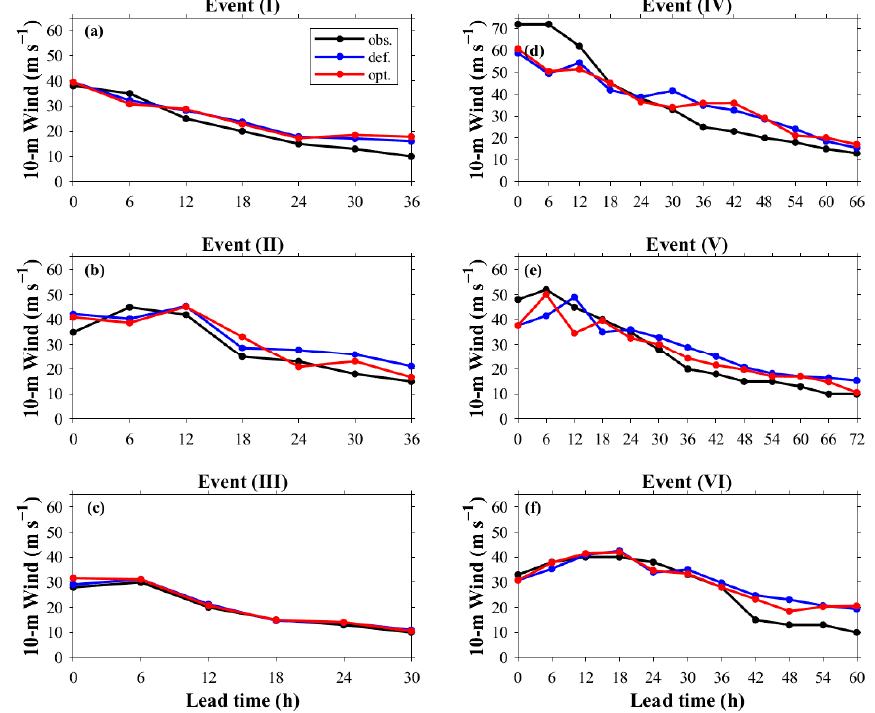
Figure 15. Comparisons of 10-m wind evolution simulations for six validation events. ( a ) − ( f ) represent the typhoon events (I) − (VI) respectively.